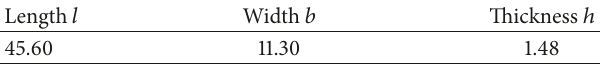
Table 2: Geometric parameters of viscoelastic material